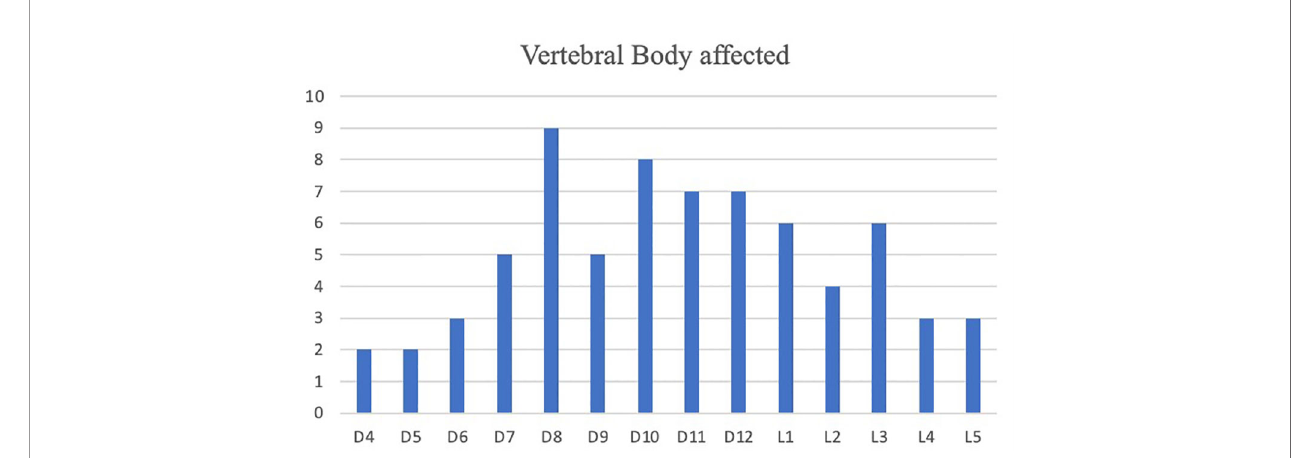
FIGURE 2 | Frequency of neoplastic vertebrae treated by radiofrequency ablation